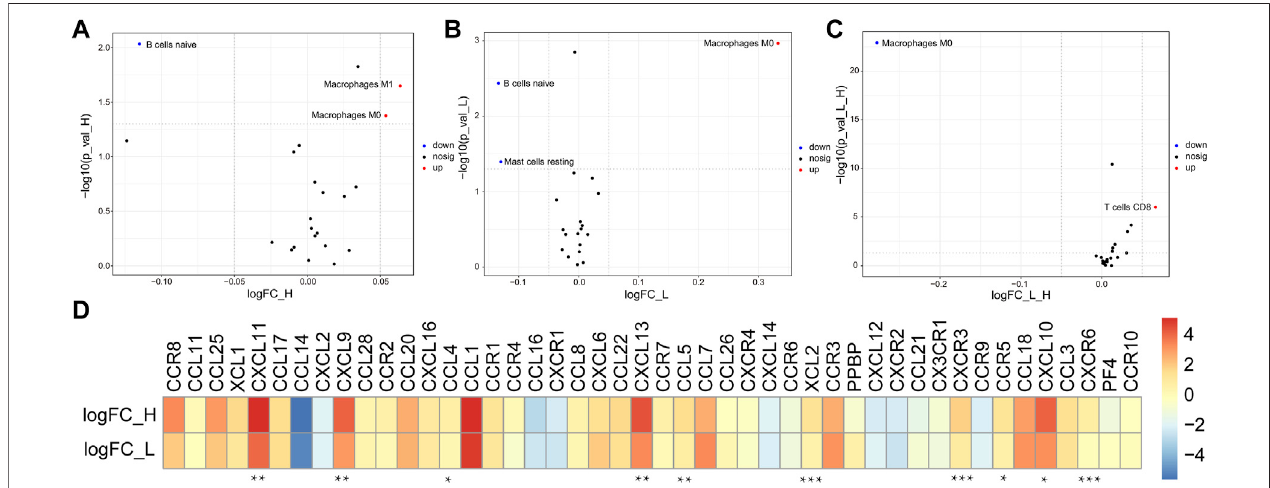
FIGURE 4 | Potential extrinsic immune escape mechanisms of BLCA. (A,B) Volcano plots of more abundant (red) and less abundant (blue) immune cells in tumor samples compared with the paired normal samples in each group. (C) The differentially abundant immune cells between ImmuneScoreH and the ImmuneScoreL are shown inavolcanoplot. (D) Log2ratioofchemokinesineachcluster.Moleculeswithsigni fi cantdifferentialexpressionbetweenImmuneScoreHandtheImmuneScoreL ( p < 0.05) are shown. * p < 0.05, ** p < 0.01, *** p <